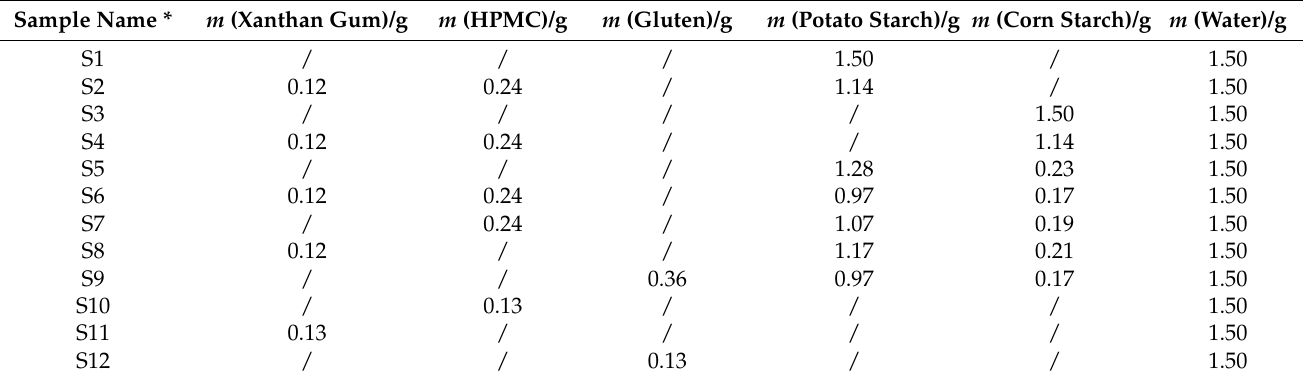
Table 1. Different model system formulations for DSC and rheological analysis. The samples in the text are referenced according to the sample name in this